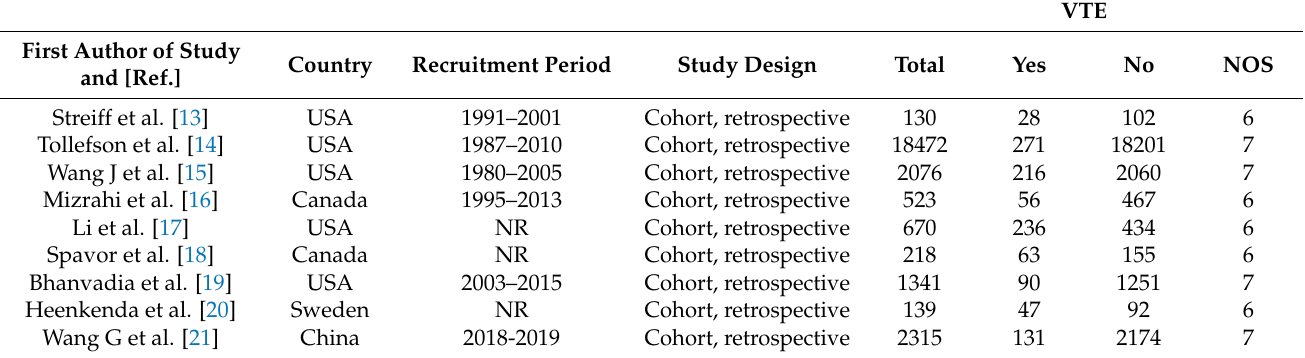
Table 1. Characteristics of all articles included in the study.